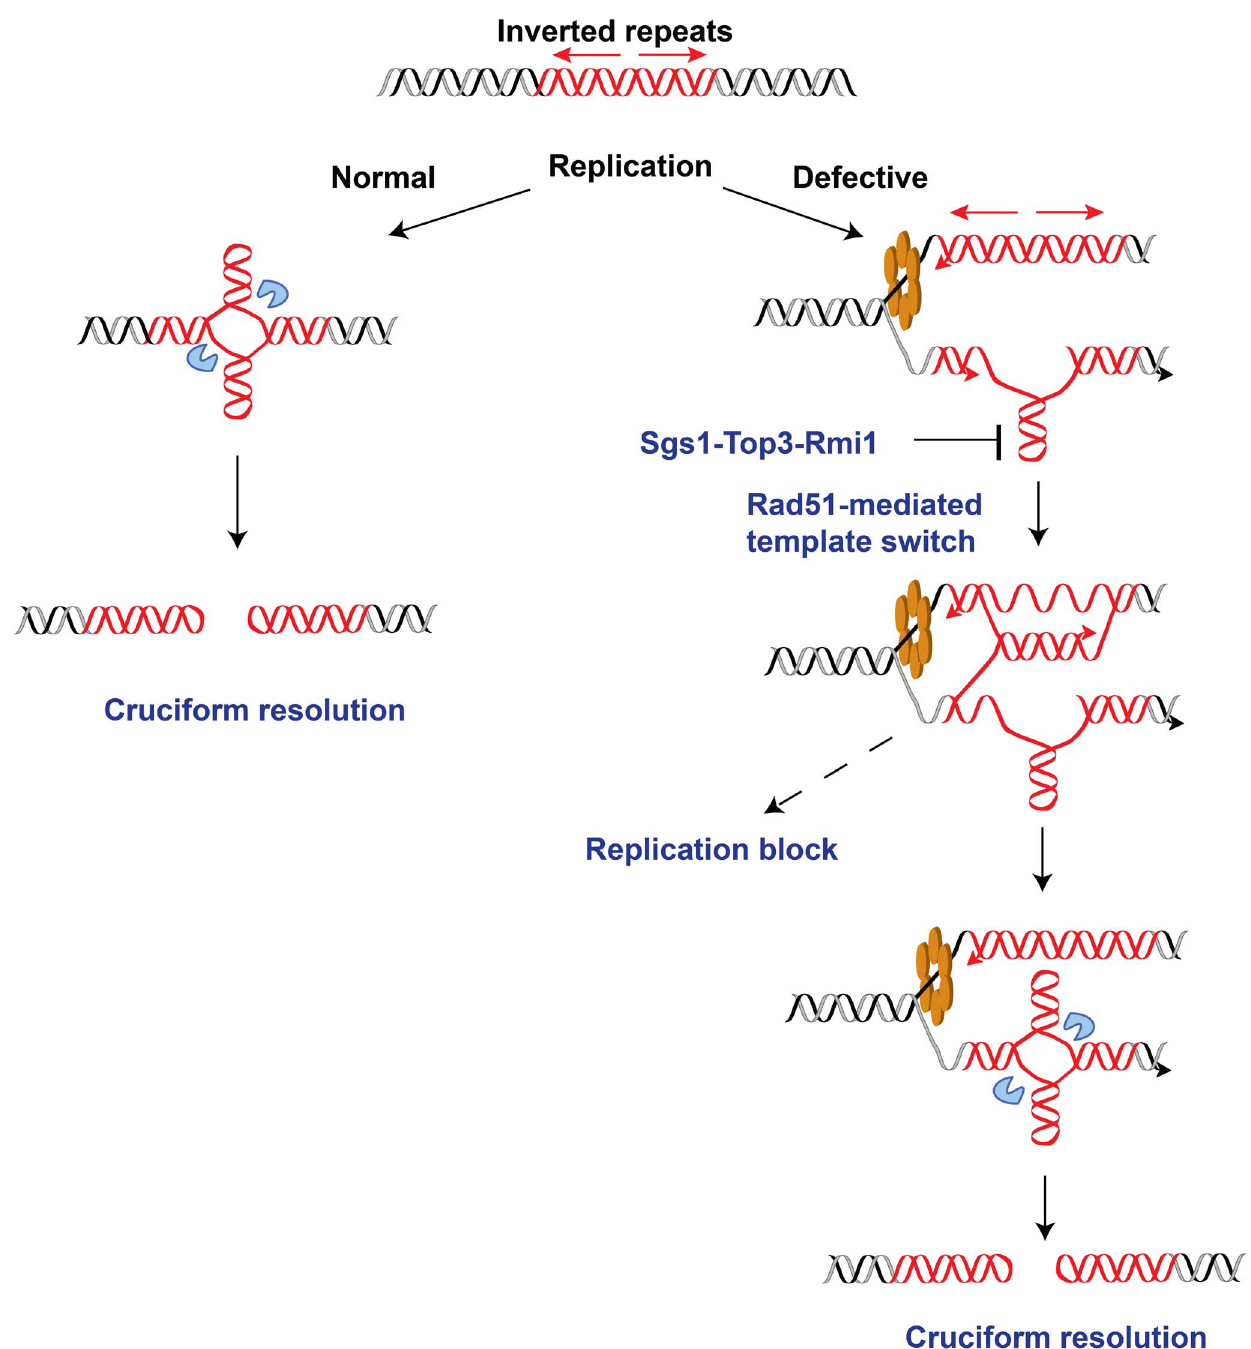
Figure 6. Model for Alu -IRs-mediated fragility under conditions of replication proficiency and deficiency. The red helixes, blue pacman and orange hexamer depict the inverted repeats, the putative nuclease and the DNA replication helicase, respectively. In the case of normal replication, cruciform structure might form outside of S-phase as a result of chromatin packing or remodeling. On the other hand, long single- stranded DNA exposed due to compromised replication would facilitate the formation of a hairpin, which could further be converted into cruciform structure via template switch by Rad51. The intermediates of template switching present a strong obstacle for the replication machinery that is manifested as replication block in the replication-deficient strains. The Sgs1-Top3-Rmi1 dissolvosome might participate in unwinding the hairpin. Once formed, the cruciform structure might be attacked by the putative nuclease, leading to DSBs at the IRs. doi:10.1371/journal.pgen.1003979.g006 observed in TET- POL3 would reflect the accumulation of arrested sequence on the unperturbed strand and reannealing of this newly forks in response to template switching rather than inhibition of synthesized DNA might allow formation of a cruciform structure DNA synthesis by the hairpin structure. Rad51 was found to be which is resolved by a putative nuclease to give rise to hairpin- present at unperturbed and stalled replication forks [74–77], and capped DSBs (Figure 6). In this case, the replication stalling